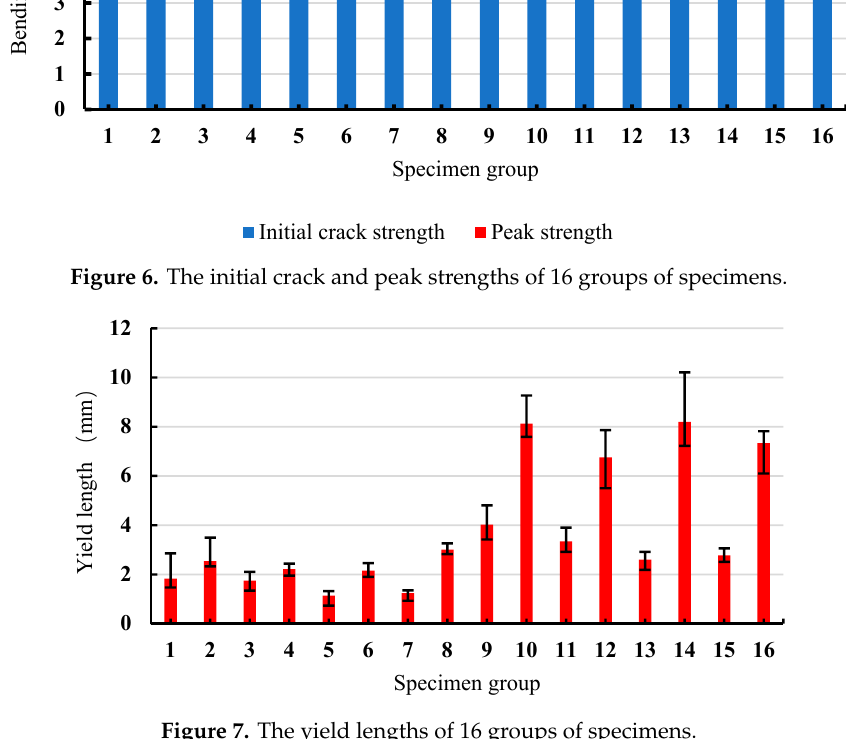
Figure 7. The yield lengths of 16 groups of specimens.